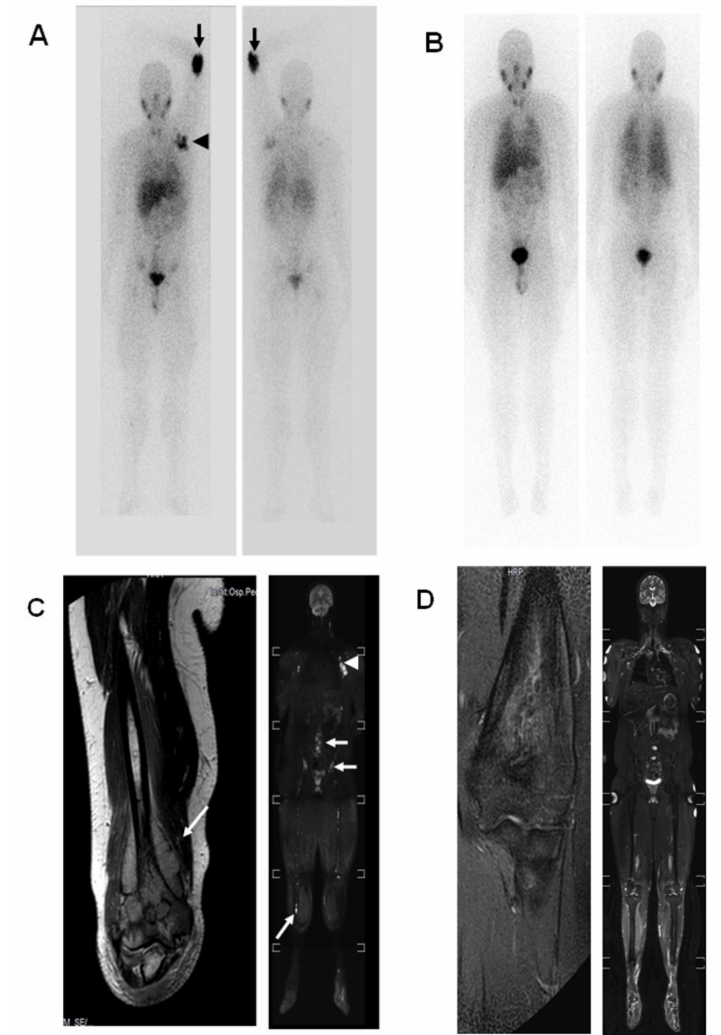
Figure 2. ( A ): Whole Body 123I-mIBG, anteroposterior and posteroanterior images. On relapse, scintigraphy revealed an intense MIBG uptake in the left elbow (arrow) and in the axillary hol- low (arrowhead). A mild uptake was seen in the proximal femurs, iliac bones and lumbar spine. ( B ). Whole-body 123I-mIBG, anteroposterior and posteroanterior images. At the end of therapy, no MIBG alterations were present. ( C ). Magnetic Resonance Imaging (MRI). Coronal T2-Turbo SpinEcho (TSE) sequence of the elbow and whole-body coronal multiplanar reconstruction diffusion-weighted imaging with background body signal suppression (DWIBS) image. On relapse, MRI of the elbow showed a large lesion involving the distal humerus and soft tissue (arrow); Whole-body DWIBS revealed increased lymph nodes in the left axillary hollow (arrowhead) and several skeletal signal alterations in the lumbar vertebrae, iliac bones, femurs and right tibia (arrows). ( D ). MRI, coro- nal T2-weighted short time inversion-recovery (T2W-STIR) of the elbow and whole-body coronal T2-weighted short time inversion-recovery (T2W-STIR) image. At the end of therapy, elbow bone remodeling with periosteal reaction was seen; a mild bone marrow signal alteration was present, owing to red bone marrow conversion. At the end of treatment, a Whole-body STIR image showed no skeletal alterations. The MRI was performed on a 1.5 Tesla scanner (Achieva D-Stream,